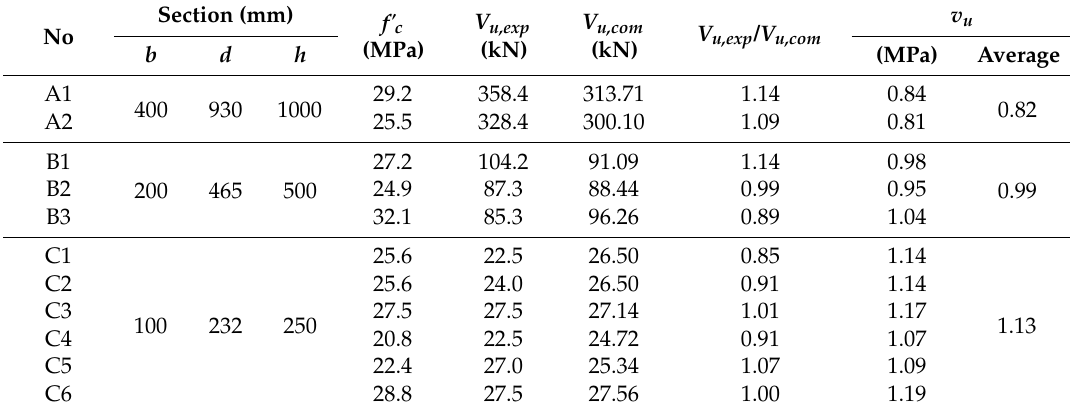
Table 5. Experimental results of the shear strength of the RC beam using natural aggregate concrete as given in Taylor [23].